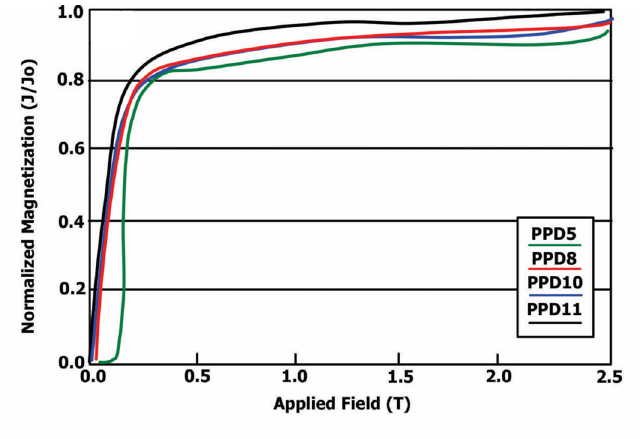
Figure A2: Isothermal Remanent Magnetization Results